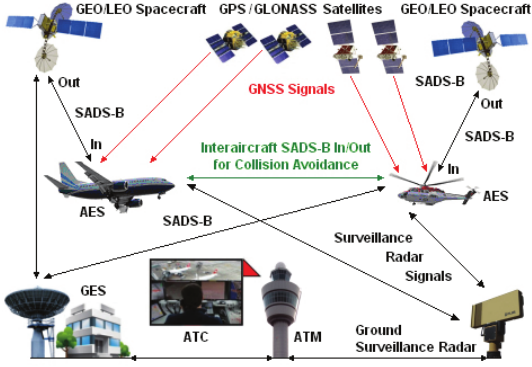
Figure 4. Aeronautical SDL Network – Courtesy of Book: by Ilcev (2013)